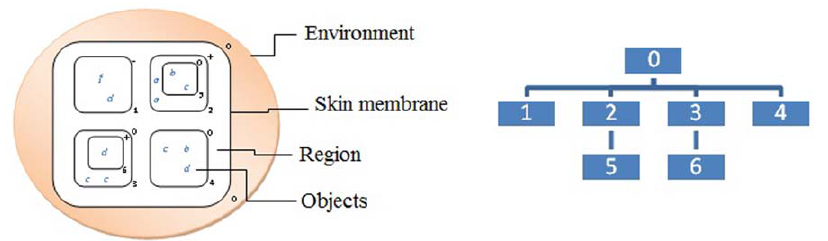
Figure 4. Graphic representation of a P-system formed by the membranes, regions and objects. The P-System is in an environment. At right the hierarchical representation of this structure of membranes.